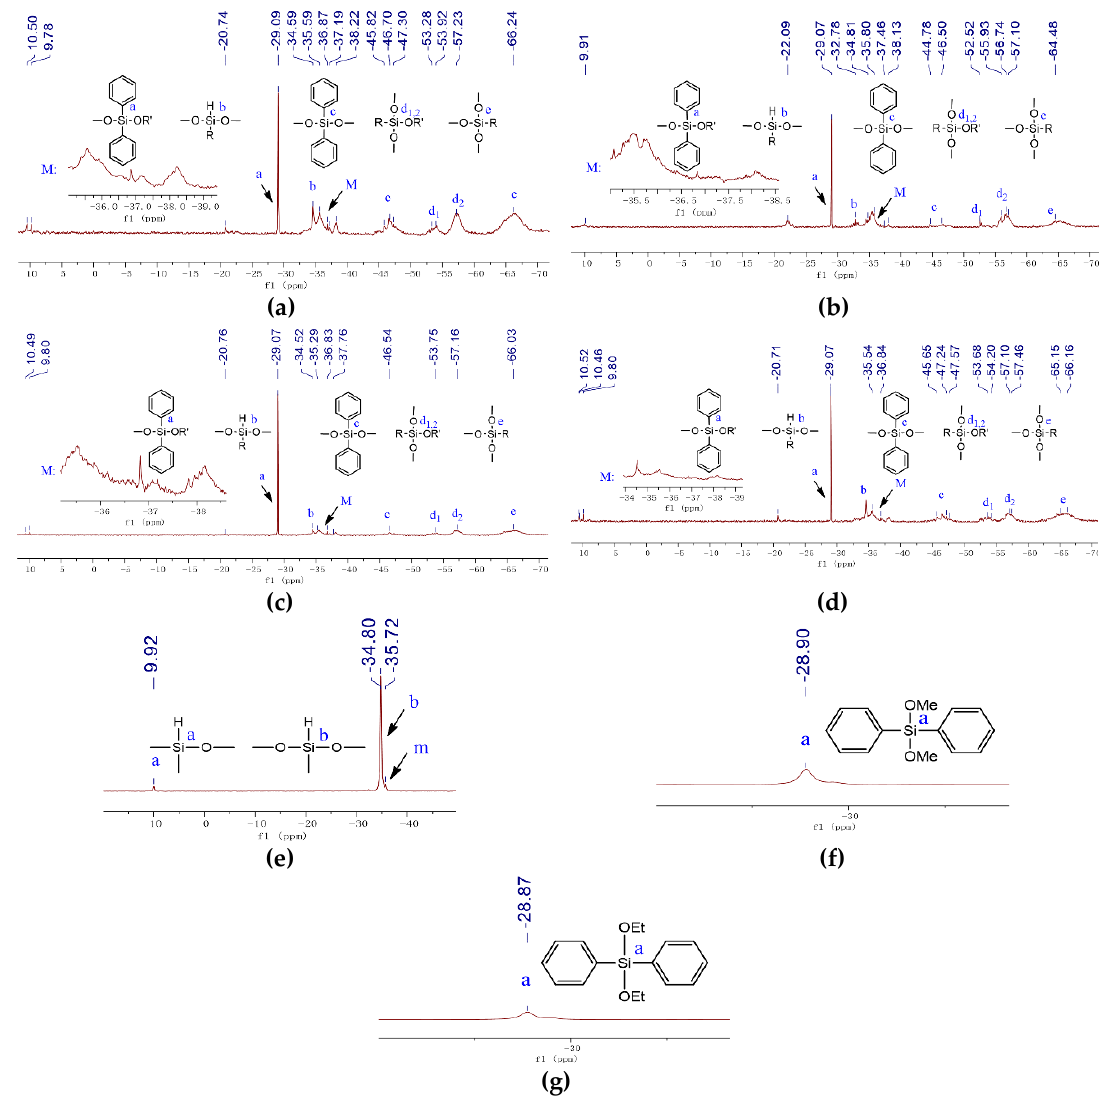
Figure 1. 29 Si nuclear magnetic resonance (NMR) spectra of D01 ( a ), D04 ( b ), D08 ( c ), D11 ( d ), HCS ( e ), DPDMS ( f ), and DPDES ( g ). M represents overclose molecular bridges. m represents small ring structure.